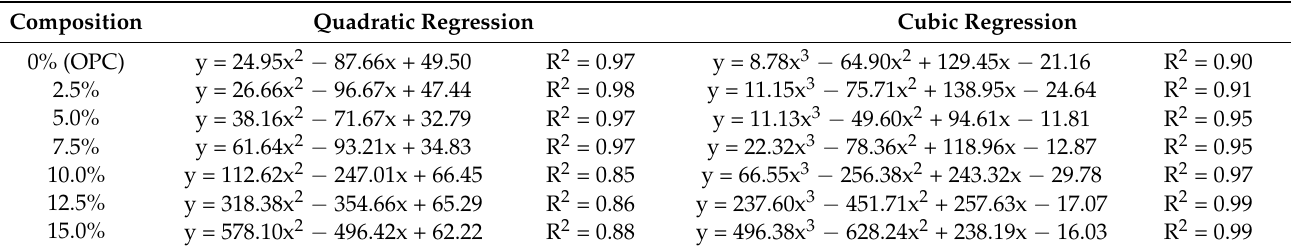
Table 3. Regression of the squeeze flow